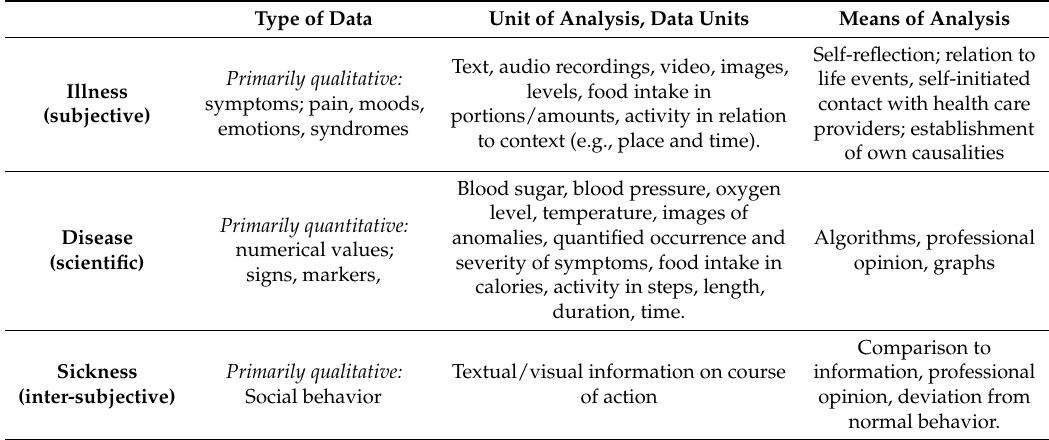
Table 1. The proposed classification system for analyzing mobile health